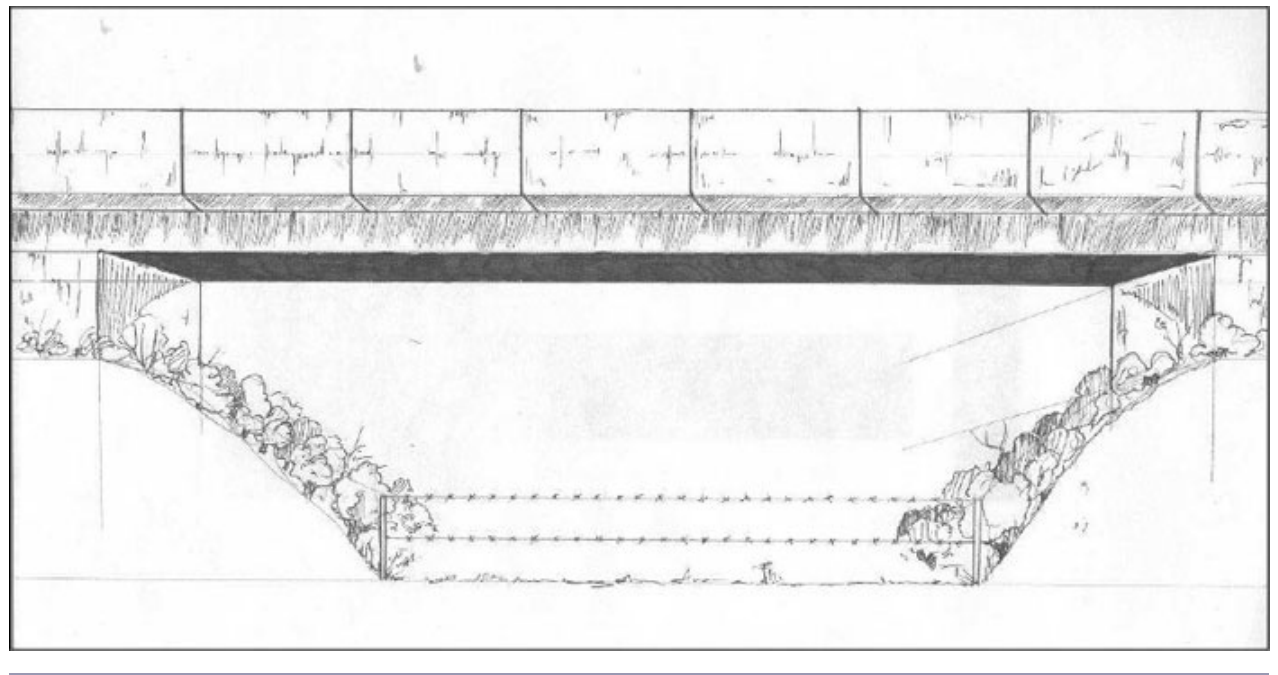
Fig. 2. Illustration of hair-sampling system at wildlife underpass in Banff National Park (Illustration by S.